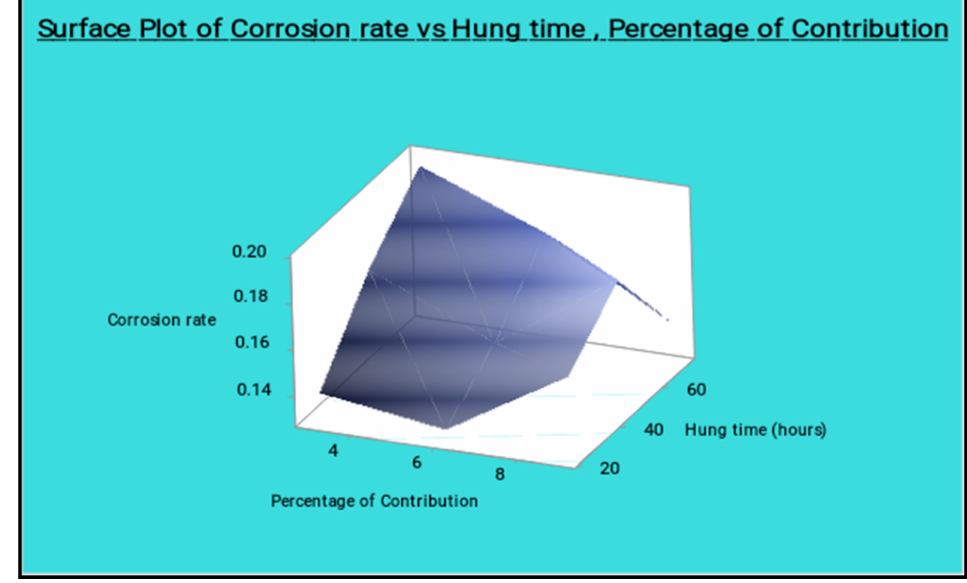
Figure 27. Surface plot of corrosion rate vs. hang time, percentage of reinforcement.